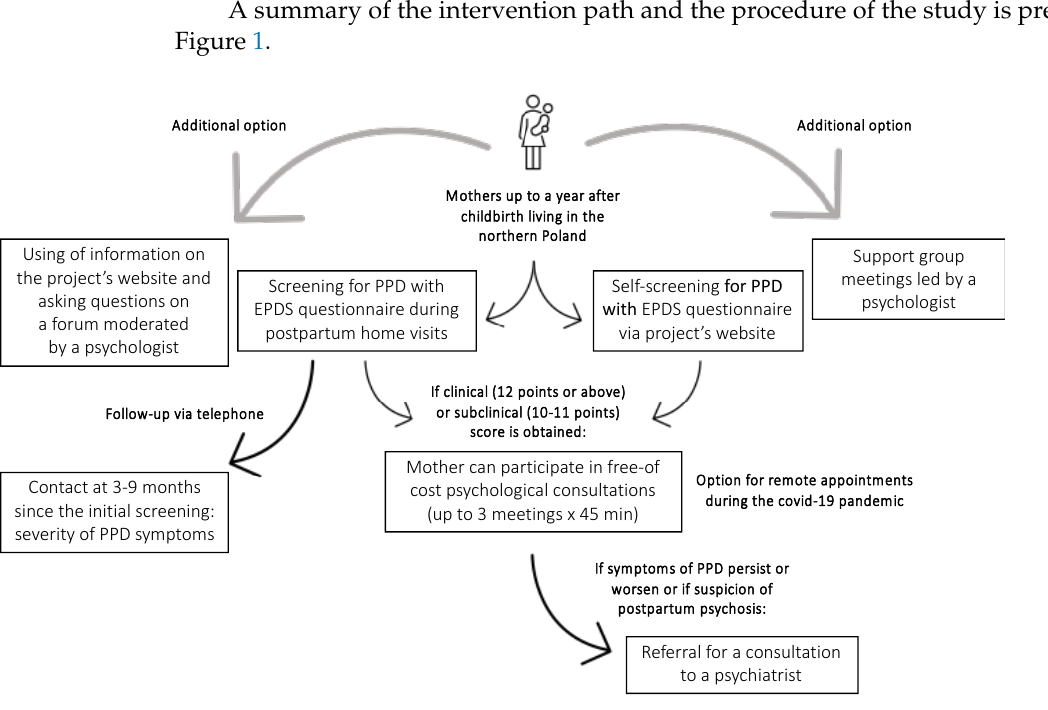
Figure 1. ‘Next Stop: Mum’ project: the path of intervention and procedure of the study .